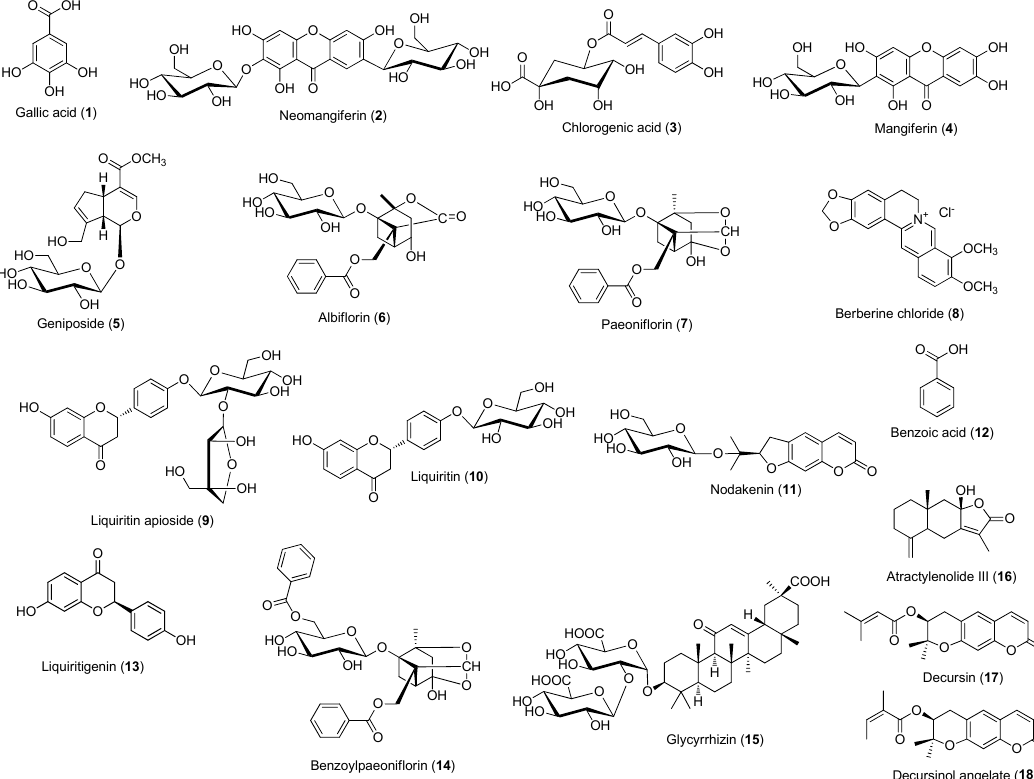
Figure 1. Chemical structures of compounds 1 – 18 present in Gami-soyosan. Table 2. Chromatographic parameters for high-performance liquid chromatography (HPLC) analysis of 18 marker components in Gami-soyosan.